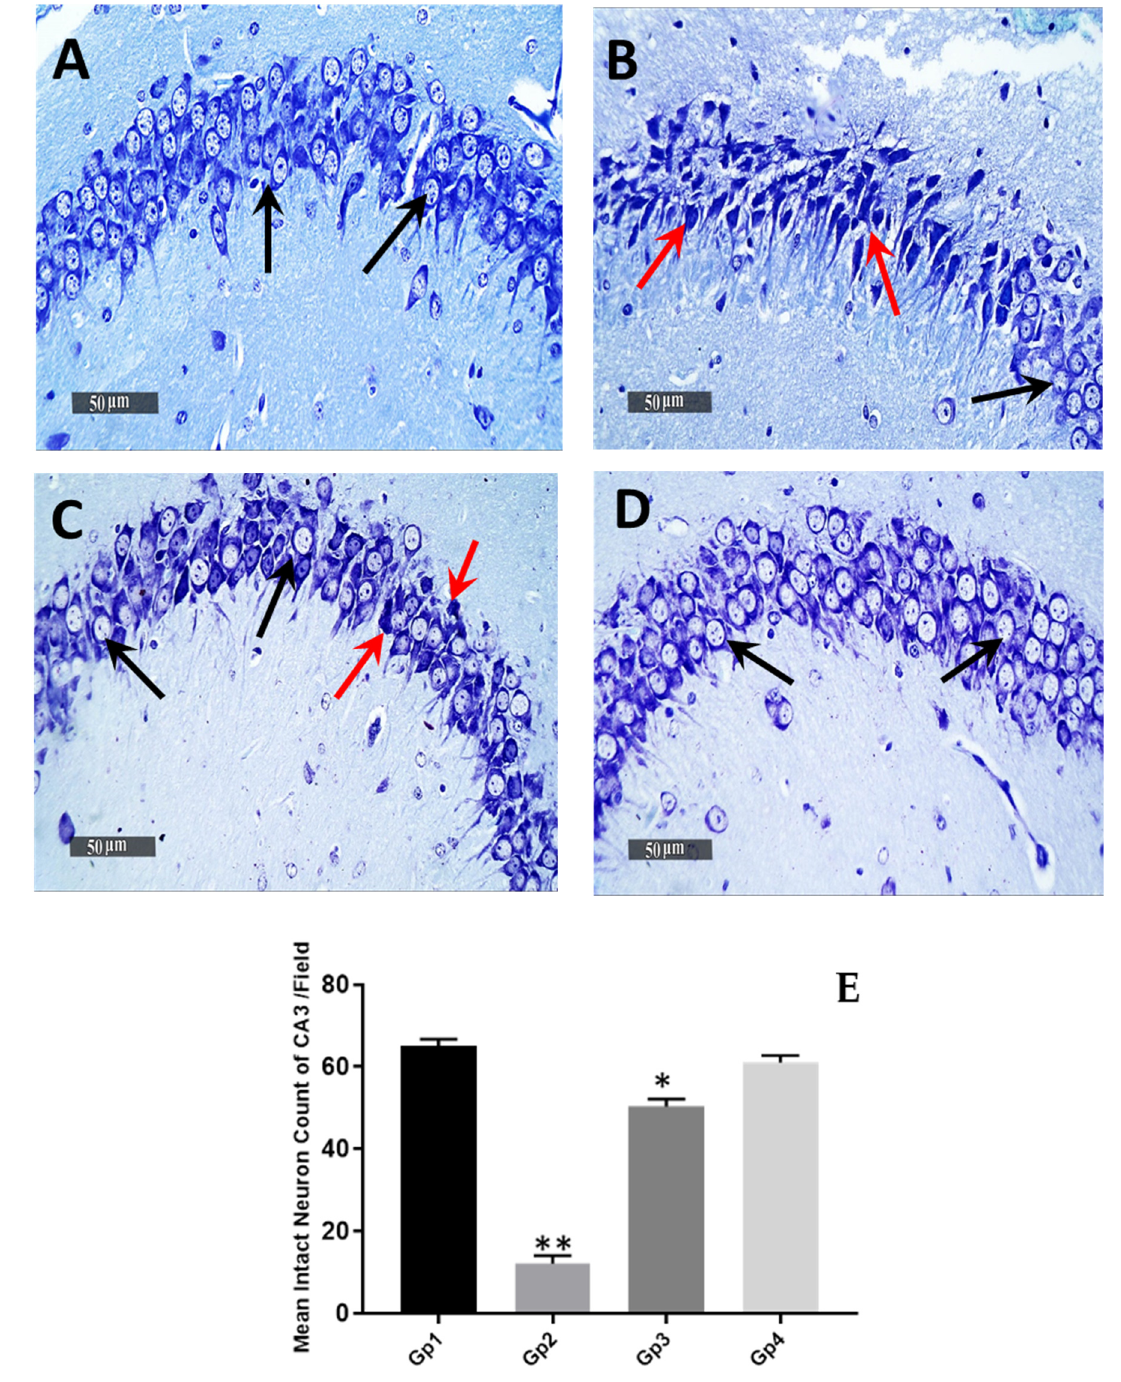
Figure 5. Neuroprotective histological effect of different treatments on CA3/hippocampal sub-regions of AD model. ( A ) normal group, ( B ) negative control group (received 0.9% saline), ( C ) positive control group (received resveratrol suspension) and ( D ) test group (received resveratrol bilosomes). H&E stain, 400×.